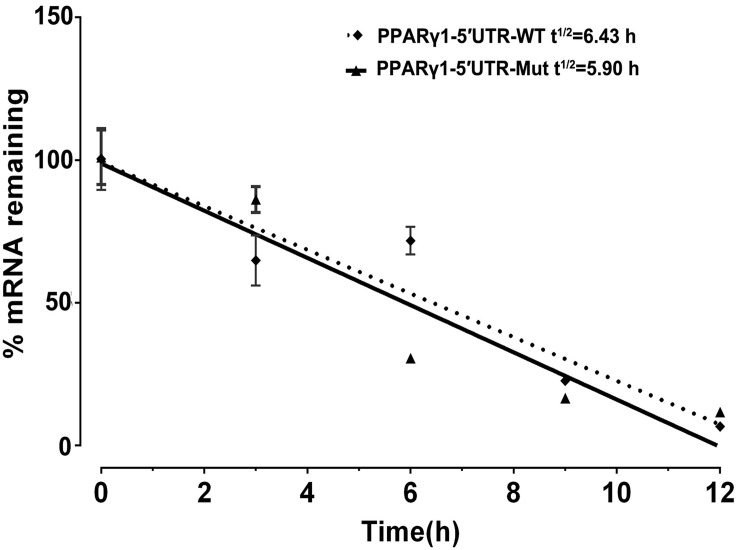
Effect of uORF mutation on Rluc mRNA stability. ICP1 cells were transiently transfected with PPARγ1-5′UTR-WT or PPARγ1-5′UTR-Mut, 48 h post-transfection, Rluc mRNA remaining after a 12 h time-course treatment with Actinomycin D was measured by real-time RT-PCR and calculated as a percentage of the level measured at time zero (0 h). Linear regression analysis was used to determine the half-life of the Rluc mRNA (t1/2), the time required for degrading 50% of the existing Rluc mRNA molecules at 0 h. No differences in relative mRNA decay rate were observed between the cells transfected with PPARγ1-5′UTR-WT and PPARγ1-5′UTR-Mut. Data were expressed as the mean ± SEM relative to NONO expression.